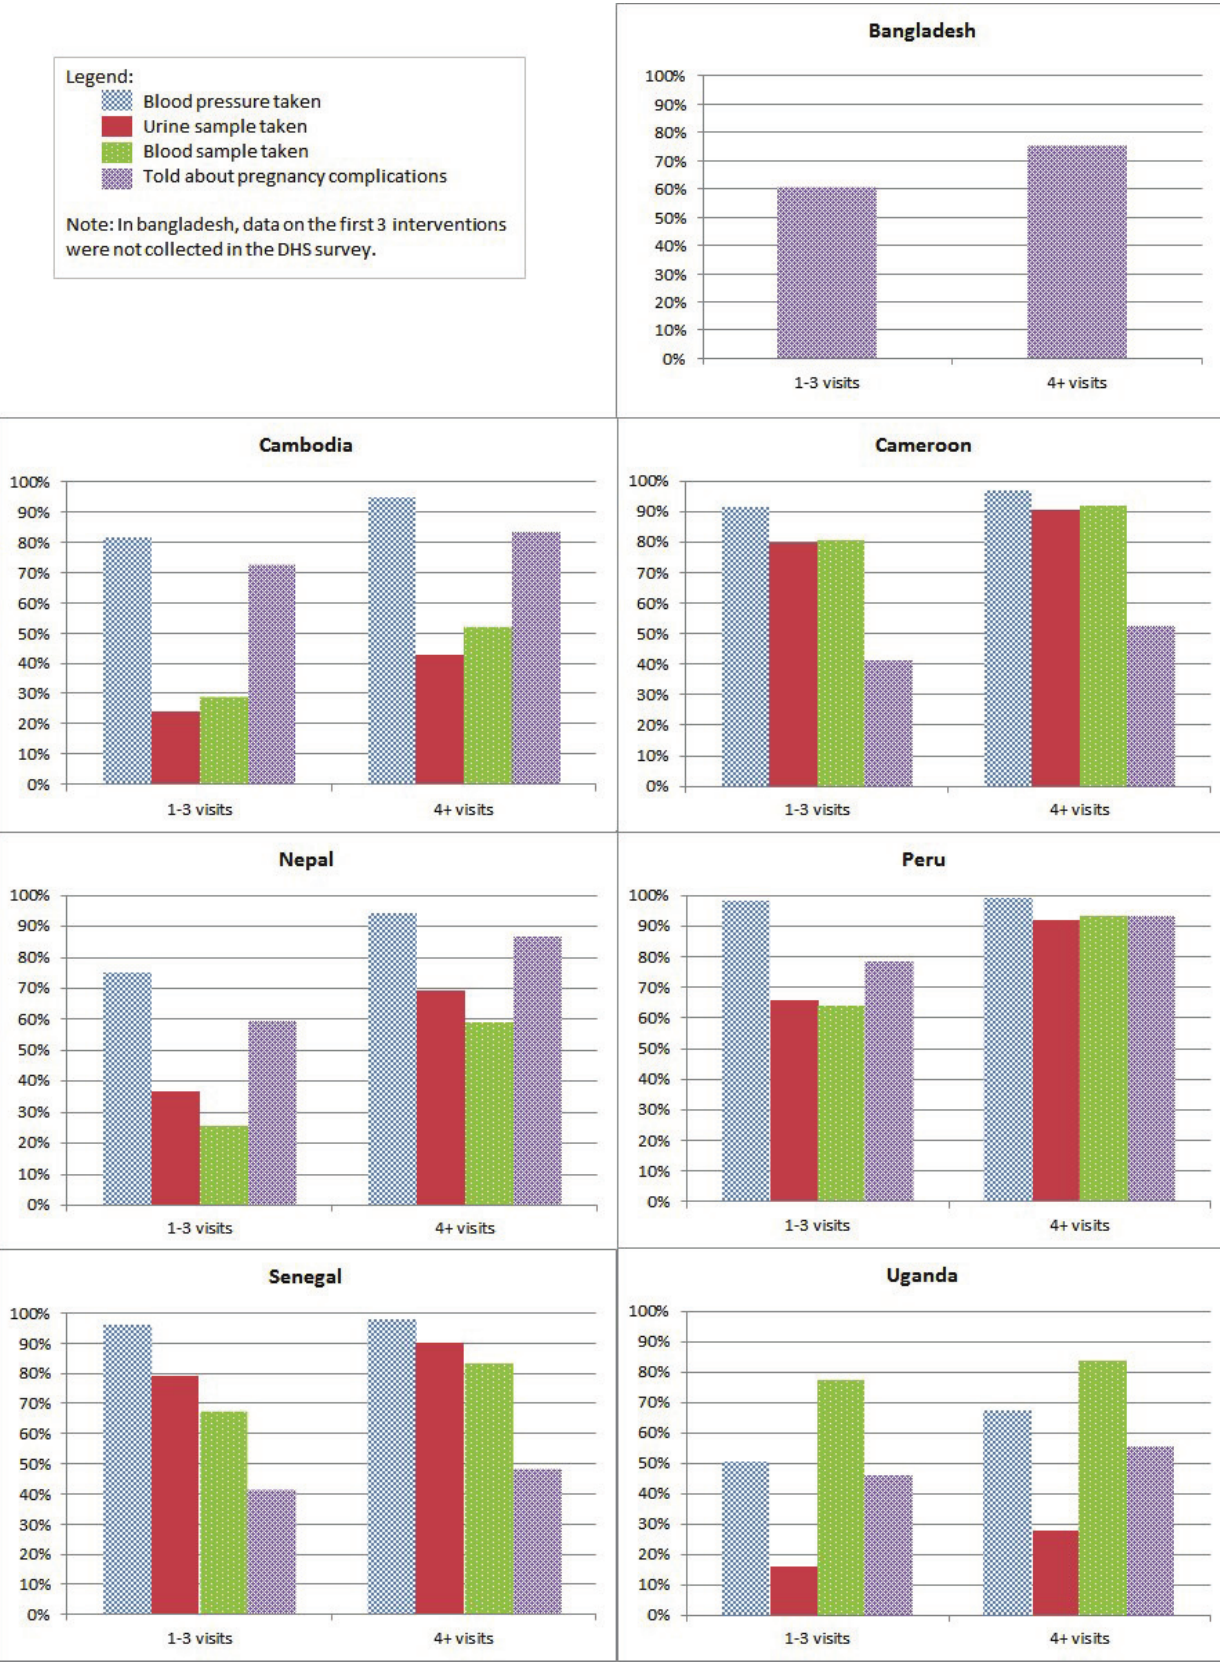
Figure 4. Percentage of women receiving content interventions during any ANC visit among women reporting one to three ANC visits or four or more ANC visits for their last live birth in the five years preceding the DHS survey, in seven Countdown